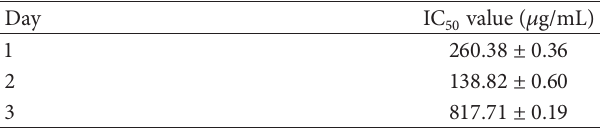
Table 4: Inhibitory concentration (IC 50 ) of the extracts (24, 36, and 48 hrs of